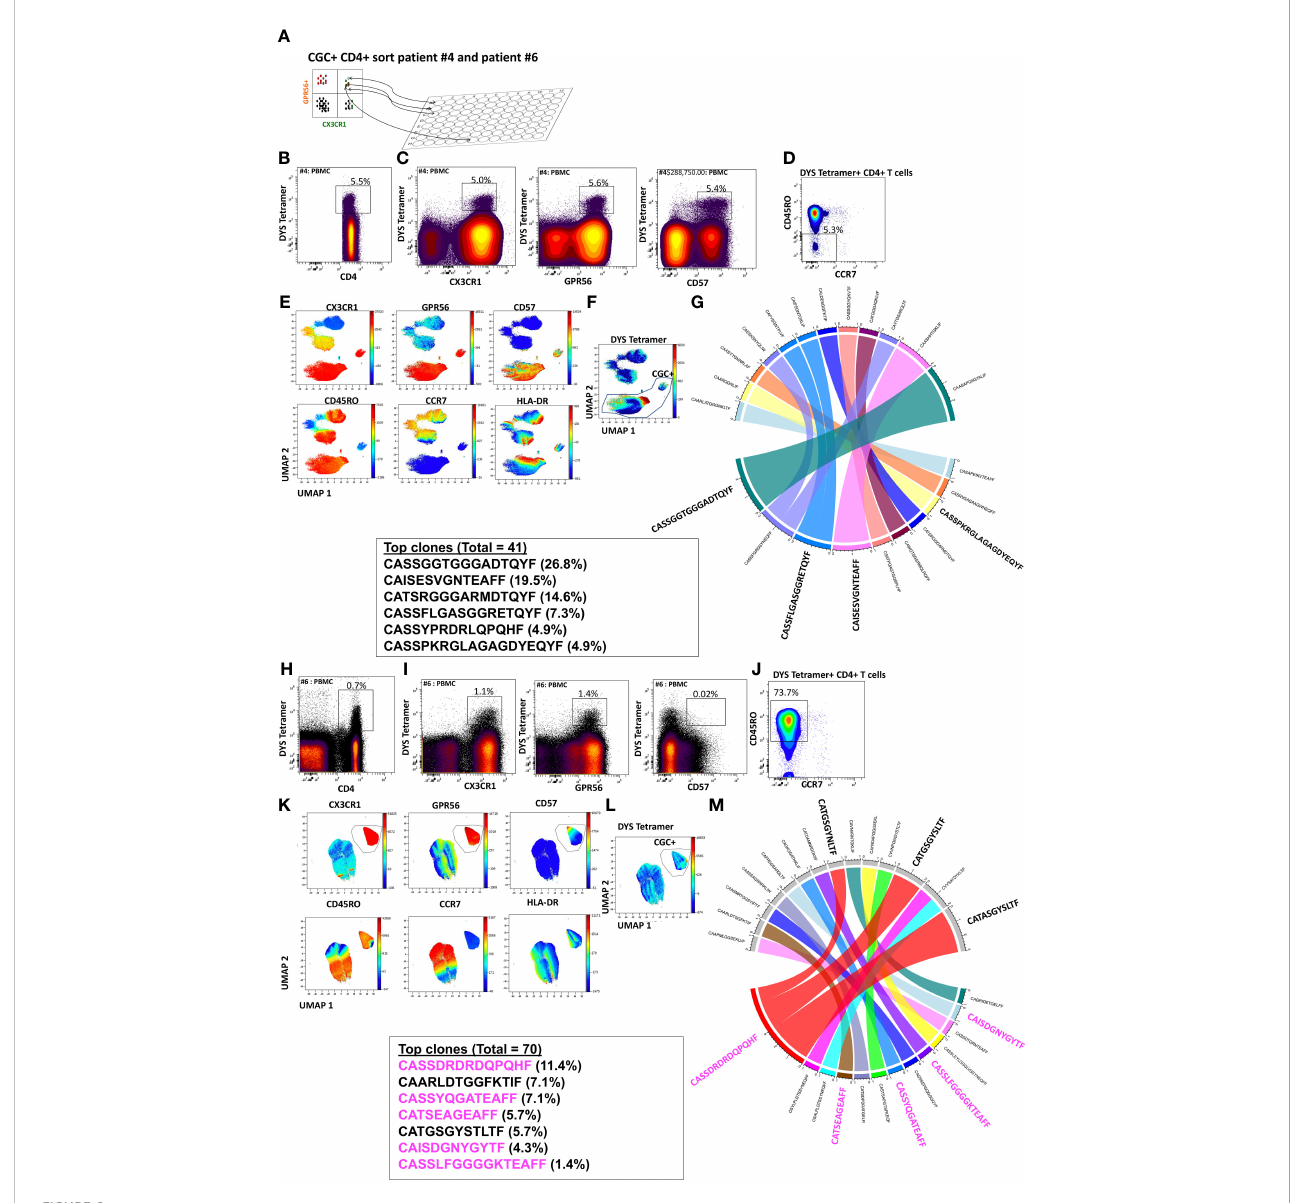
FIGURE 6 CGC + CD4 + T cells express clonal TCRs and are largely CMV-speci fi c. Single CGC + CD4 + T cells were sorted into 96 well plates as shown (A) . Two- dimensional plots from participant #4 show DYS tetramer-speci fi c T cells as a proportion of CD4 + T cells (B) . CX3CR1, GPR56, and CD57 expression on DYS tetramer + cells (C) and memory distribution of the tetramer + cells are shown (D) . UMAPs show the distribution of markers (E, F) . A total of 40 paired TCRs had identi fi able sequences. The Circos plot shows paired ab TCR CDR3 sequences, and TR b V and paired TCRJ genes are shown (G) . A similar analysis was done with participant #6 (H-M) . CDR3 sequences in magenta have previously been shown to be DYS-speci fi c, by tetramer